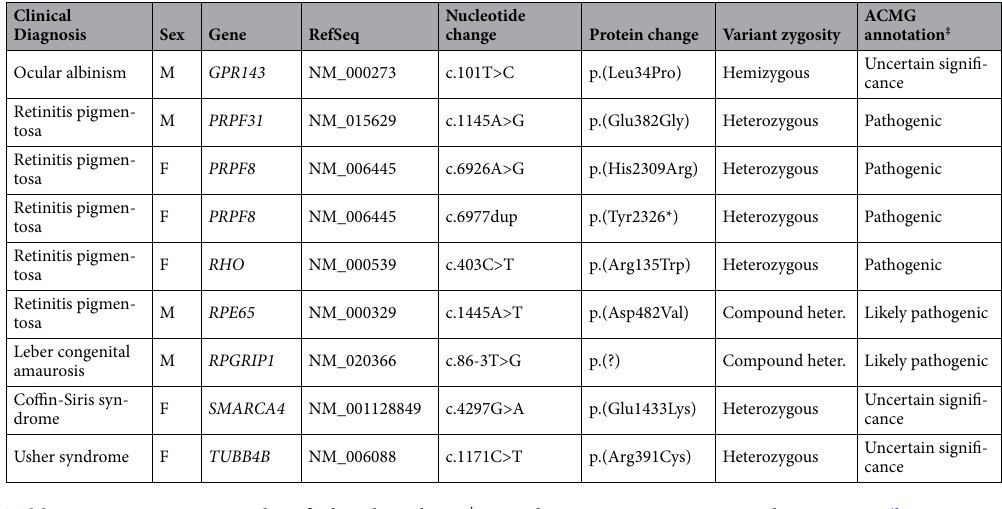
Table 5. De novo variants identified in the cohort. ‡ According to Varsome automated annotation (https:// varso me.